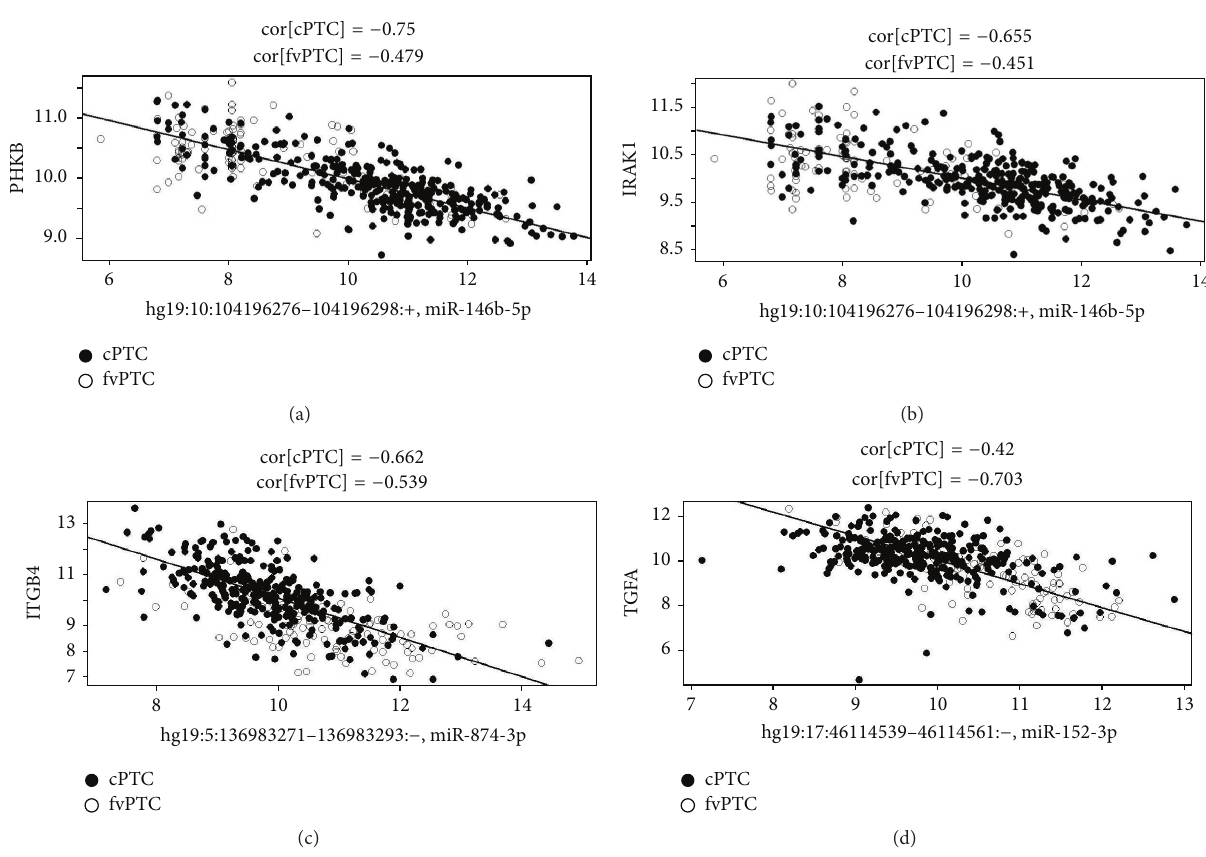
Figure 3: Putative miRNA-gene regulations. Pairs hsa-miR-146b-5p with PHKB (a), hsa-miR-146b-5p with IRAK1, (b) and hsa-miR-874-3p with ITGB4 (c) were selected from best inverse Spearman’s correlations (below − 0.65) within 321 cPTC samples and confirmed with miRanda, TargetScan,andTargetRankpredictionalgorithms.Pairhsa-miR-152-3pwithTGFA(d)wasselectedfrombestinverseSpearman’scorrelations (below − 0.70) within 99 fvPTC samples and confirmed with miRanda, TargetScan, and TargetRank algorithms. Gene expression values were plotted on 𝑦 -axis whereas miRNA expression values on 𝑥 -axis. Both cPTC (filled dots) and fvPTC (empty dots) samples are depicted. Lines on graphs represent regression lines (gene expression values ∼ miRNA expression values) for cPTC samples ((a), (b), (c)) and regression line for fvPTC samples (d). Approximated correlation coefficients ( 𝑟 ) are calculated for both cPTC and fvPTC samples and presented in the above